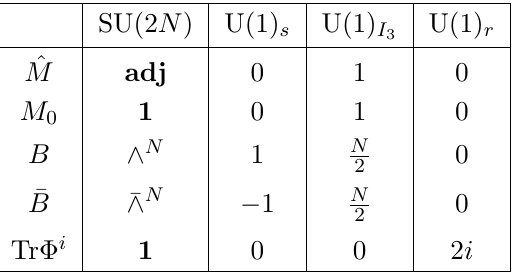
Table 3 . Charges of the gauge invariant operators of N = 2 SQCD with 2 N